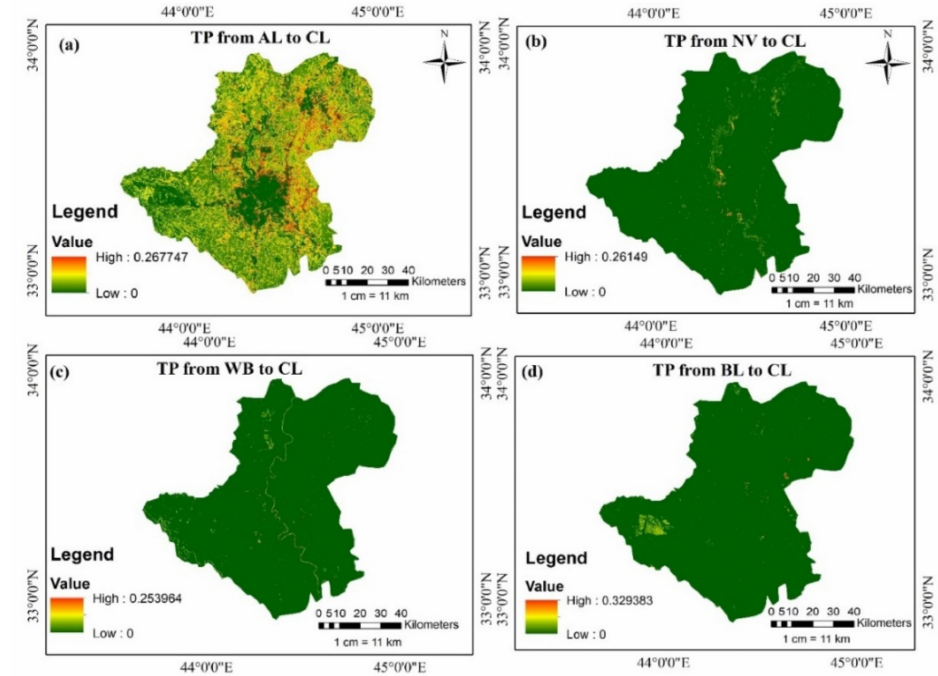
Figure A2. Modeling LUCC transition probability (TP). ( a ) TP from AL to CL; ( b ) TP from NV to CL; ( c ) TP from WB to CL; ( d ) TP from BL to